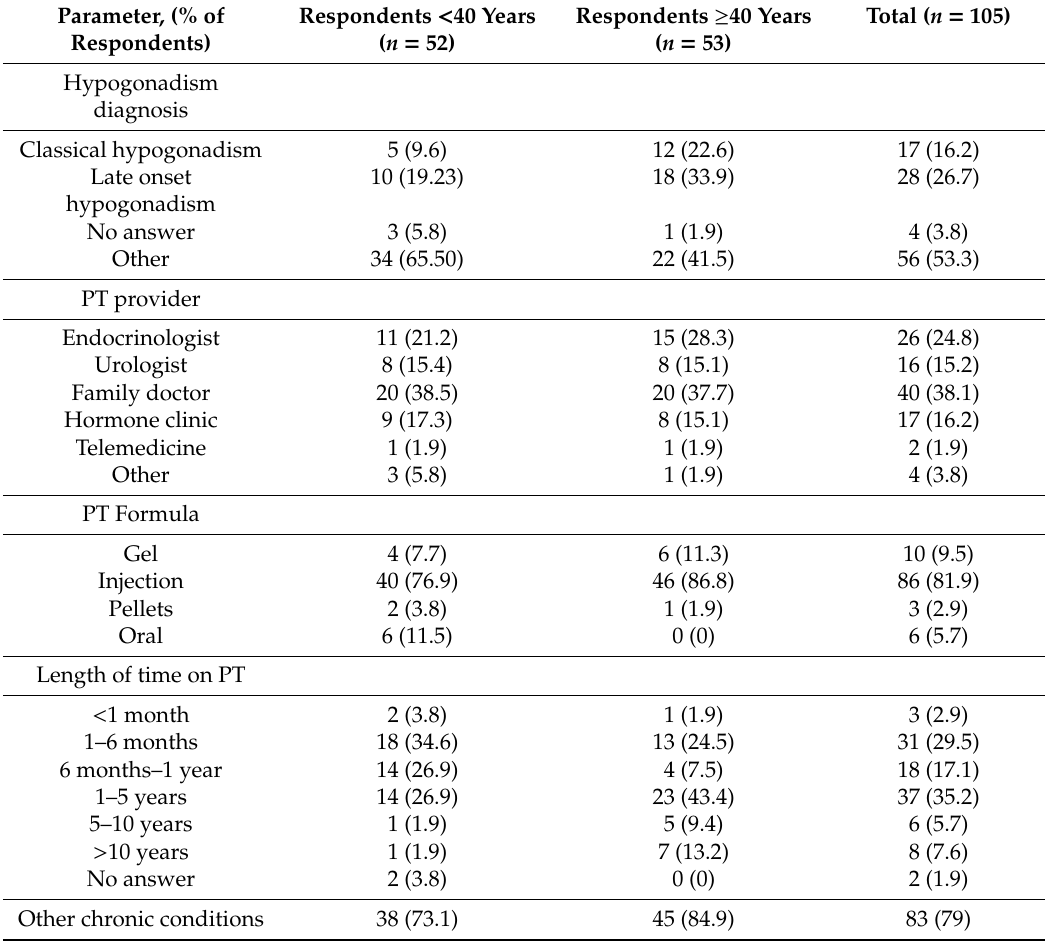
Table 3. Clinical characteristics of survey